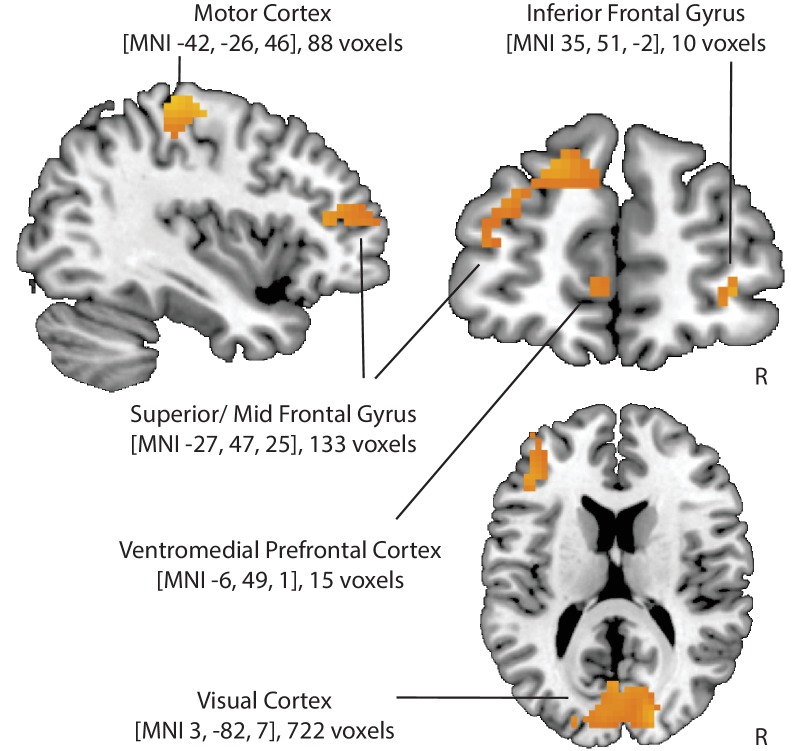
Conjunction of brain areas that encoded trial-by-trial values of all attributes.Attribute values for Healthiness, Tastiness, $Self, $Other, Fairness. Each attribute was thresholded at p < 0.001, cluster-level corrected, k = 10 voxels. Not displayed are clusters in the supplemental motor area ([MNI −3 26, 46], 43 voxels) and visual cortex ([MNI −28,–85, 32], 15 voxels, [MNI −21,–67, 40], 10 voxels). Coordinates refer to center of mass for the identified clusters in MNI space (Montreal Neurological Institute), R = right hemisphere.